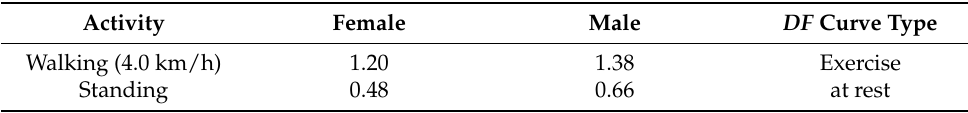
Table 1. Minute ventilation ( V E , m 3 /h) for adult subjects.